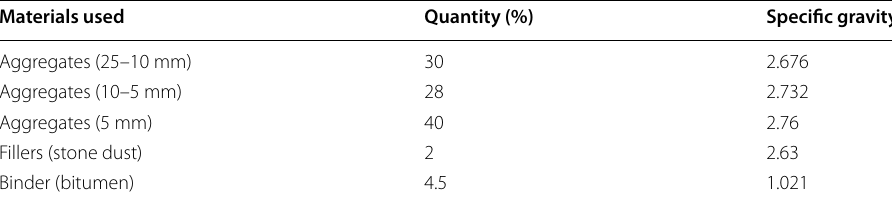
Table 4 Job mix for 50 mm BM Materials used Quantity (%) Aggregates (22.4